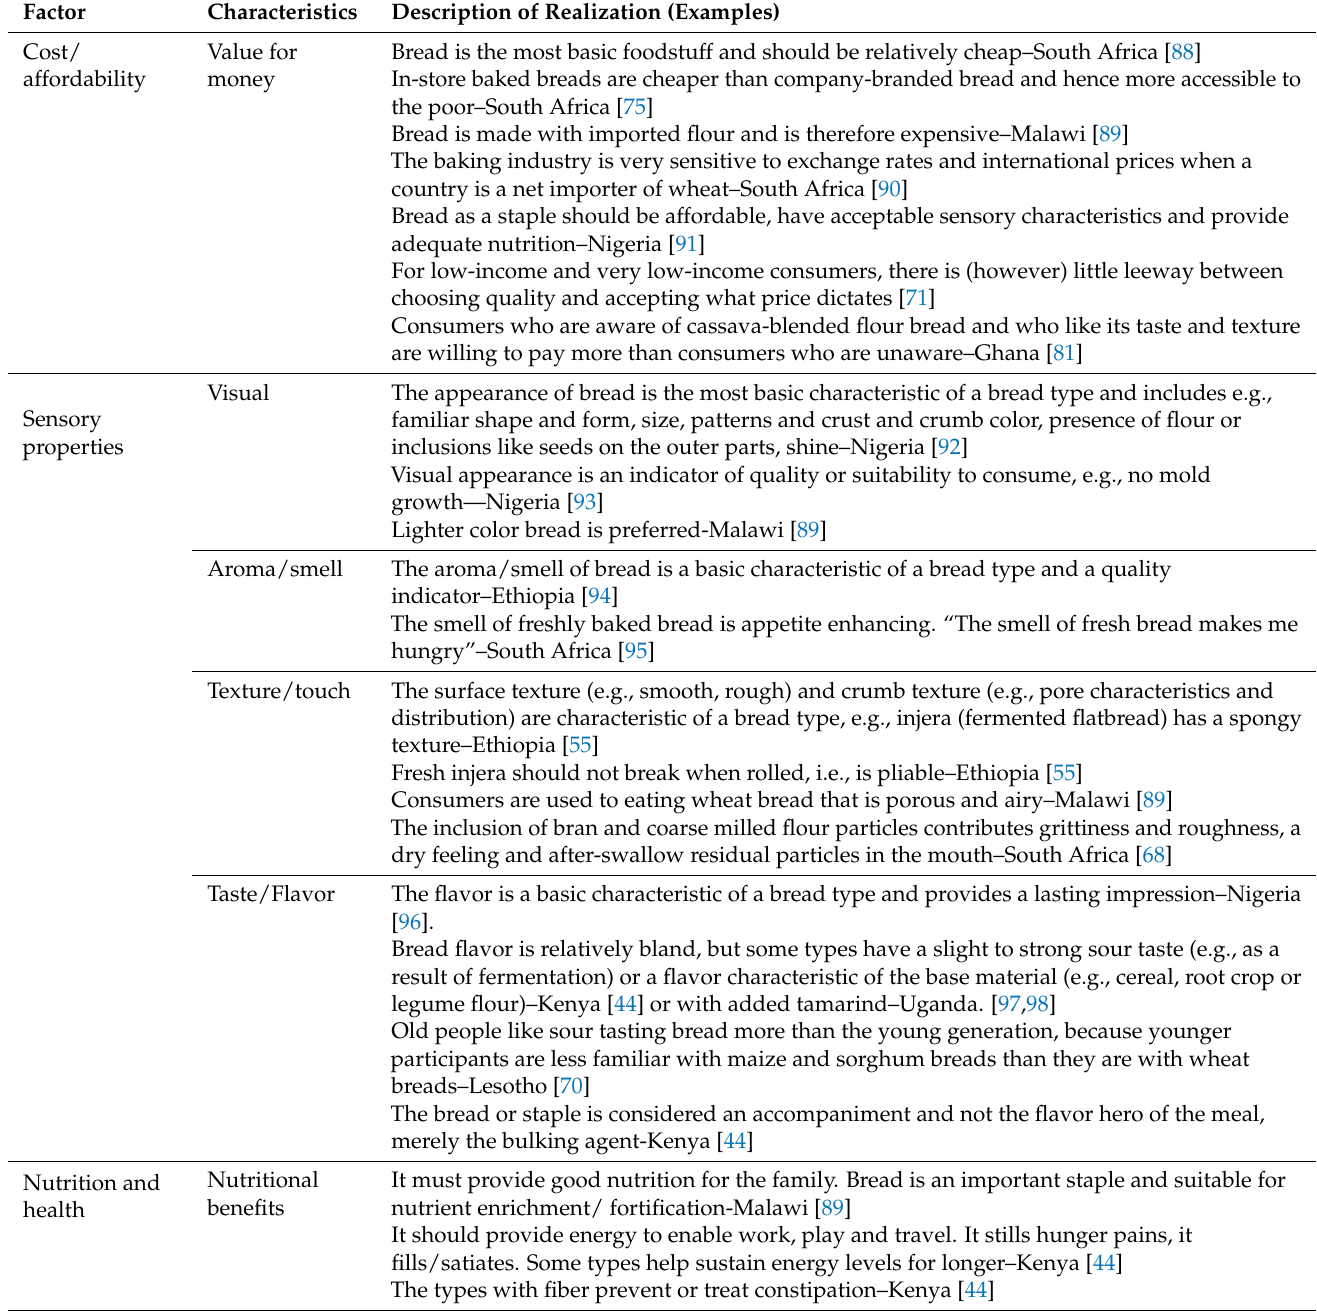
Table 2. Examples of factors and characteristics that consumers in various sub-Saharan African countries consider when judging the value of